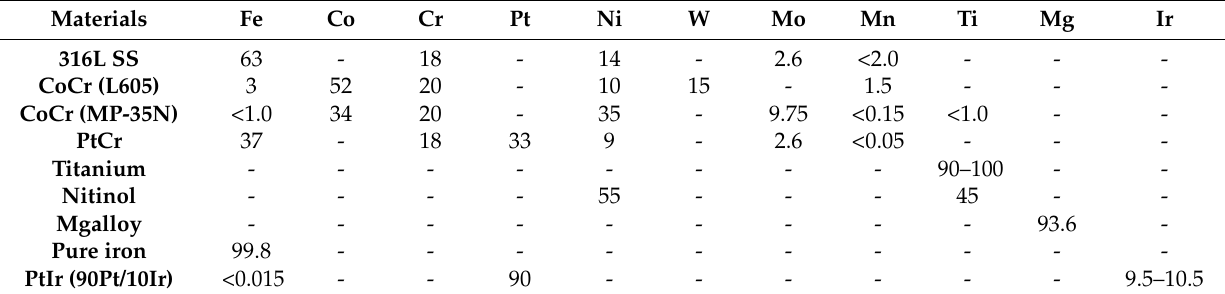
Table 1. Composition of stent alloys (wt. %).